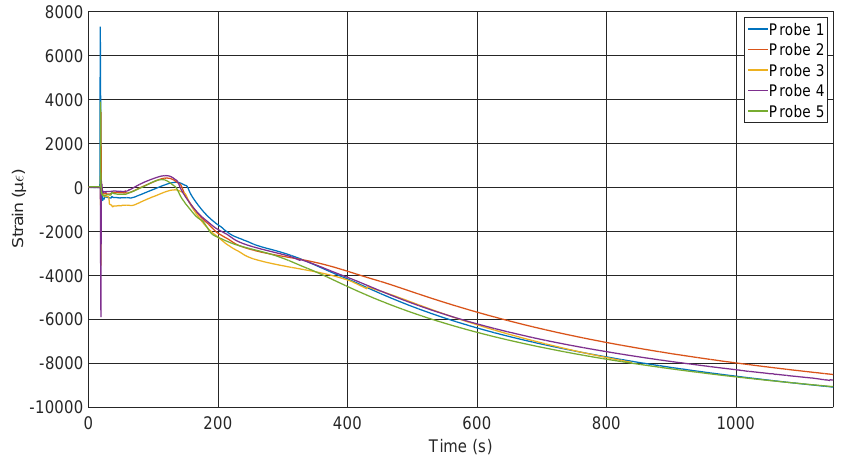
Figure 10. Strain curves during the solidification process measured by FBGs along the flow direction of the melt.